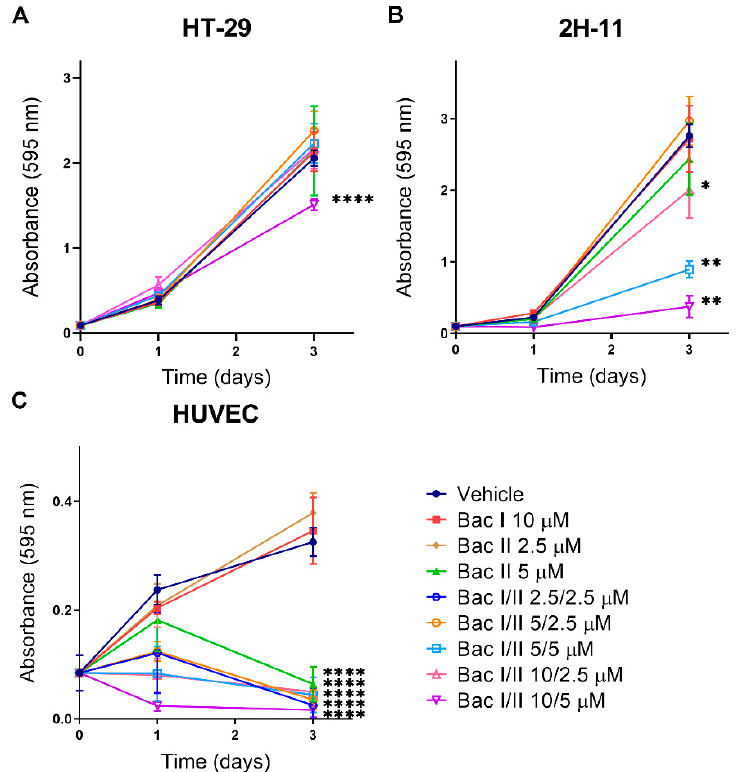
Figure 2. Bac I and II combined impaired proliferation of HT-29, 2H-11 and HUVEC. HT-29 ( A ), 2H-11 ( B ), and HUVEC ( C ) were treated with bac I and II, either alone or in combination, and cellular proliferation was measured over 3 days by a crystal violet assay. Data represent the mean absorbance of 5 to 6 replicates. Error bars represent the standard deviation (SD). Significant difference as compared to vehicle after 3-day treatment is indicated by asterisks (* p < 0.05; ** p < 0.01; **** p < 0.0001).